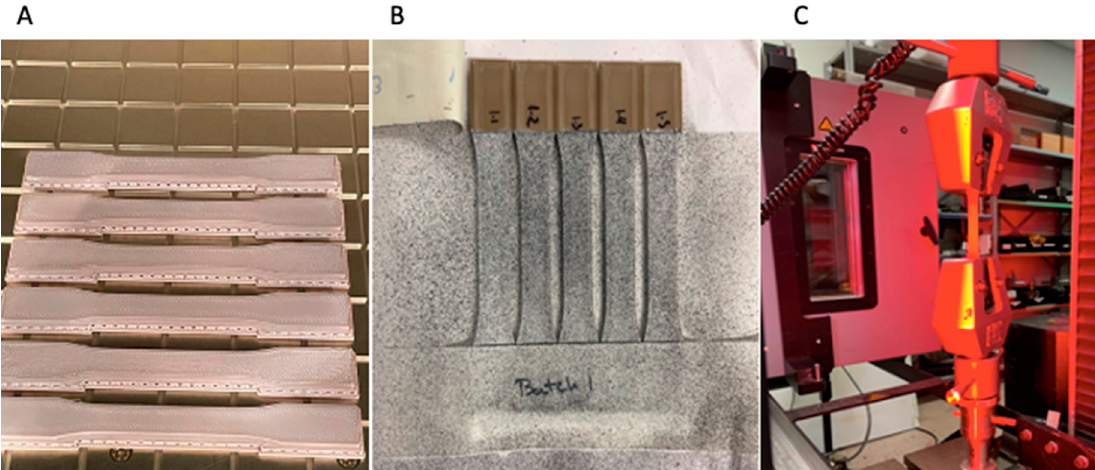
Figure 4. ( A ) printed dog bone coupons; ( B ) coupons were painted with a dot pattern so DIC could measure strain variations; ( C ) DIC-equipped Instron to measure strain using a video extensometer.